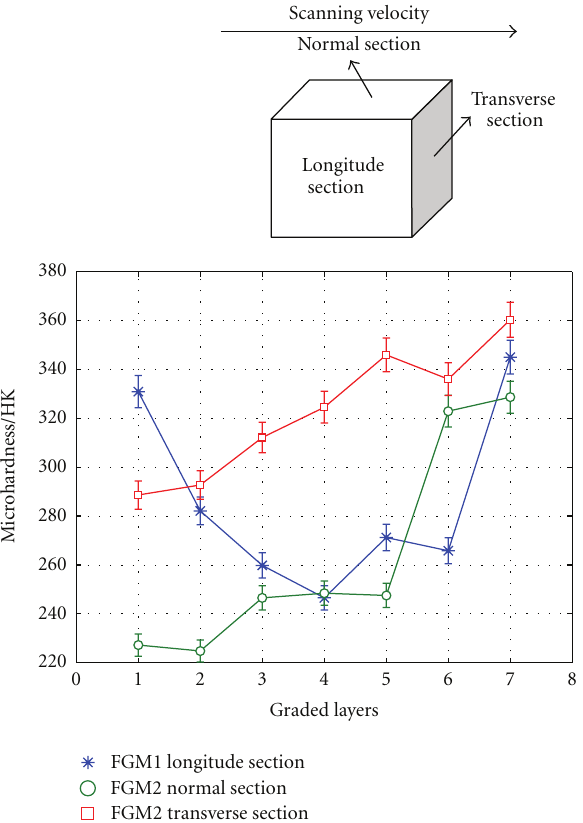
Figure 5: The microhardness along the graded